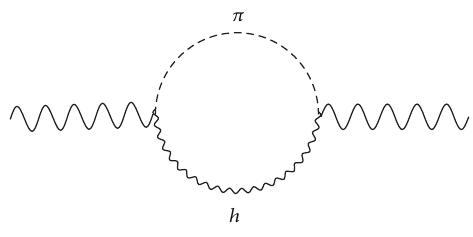
Figure 4: 𝜋ℎ self-energy diagrams where ℎ stands for 𝜋 , 𝜔 , ℎ 1 , and 𝑎 1